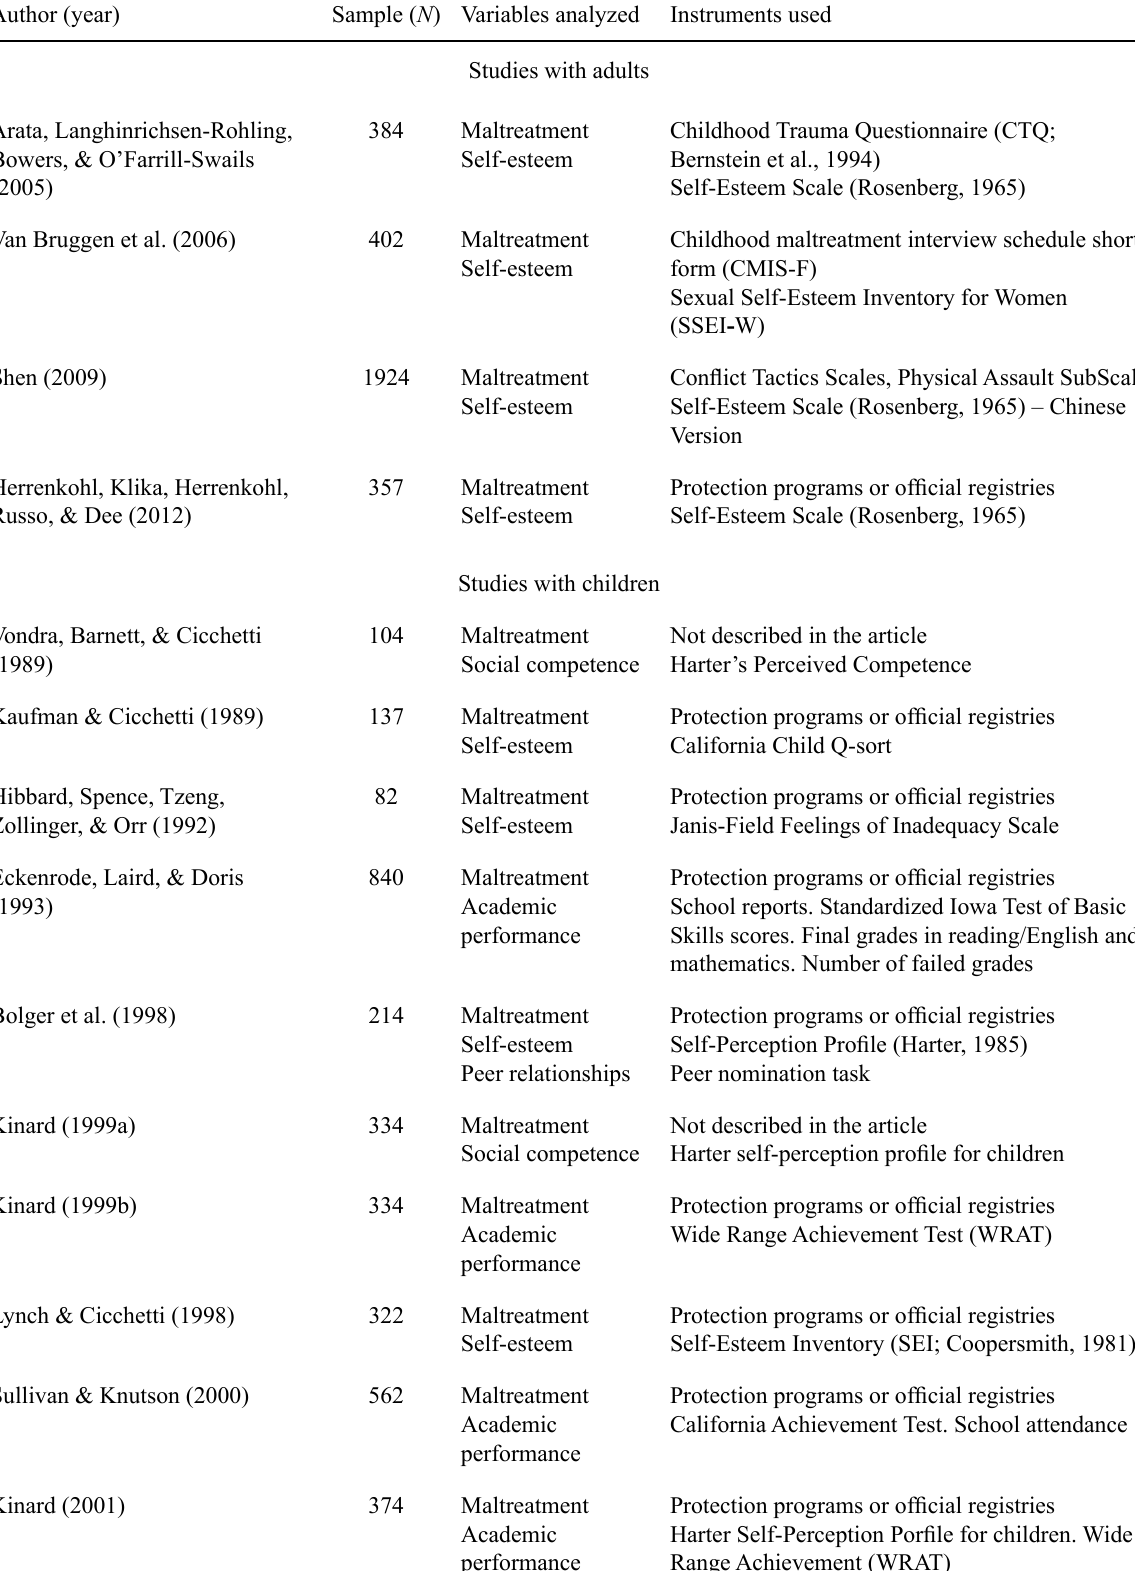
Table 1 Description of the Selected Studies, Including Sample Size, Variables Analyzed and Instruments Used Author